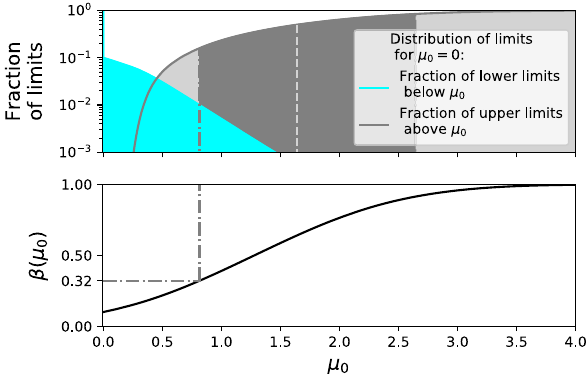
Fig. 5 Distribution of upper and lower limits for a Feldman & Cousins (FC) interval for a Gaussian measurement of a mean μ 0 = 0 and σ = 1 with a physical constraint of 0 ≤ μ 0 , as an idealized analogue to Fig. 4. The upper panel shows the fraction of signals excluded by an upper limit (gray) and lower limit (cyan), while the lower panel shows the power, π(μ 0 ) , to discover a p < 0 . 1 excess as a function of the signal. The dark gray band of the upper panel shows the central 68% band of upperlimits,typicallyshownasthesensitivitybandbyexperiments.The dash-dotted line shows that for a 90% FC construction and a Gaussian measurement, the lower edge of the sensitivity band corresponds to a power of 0 .